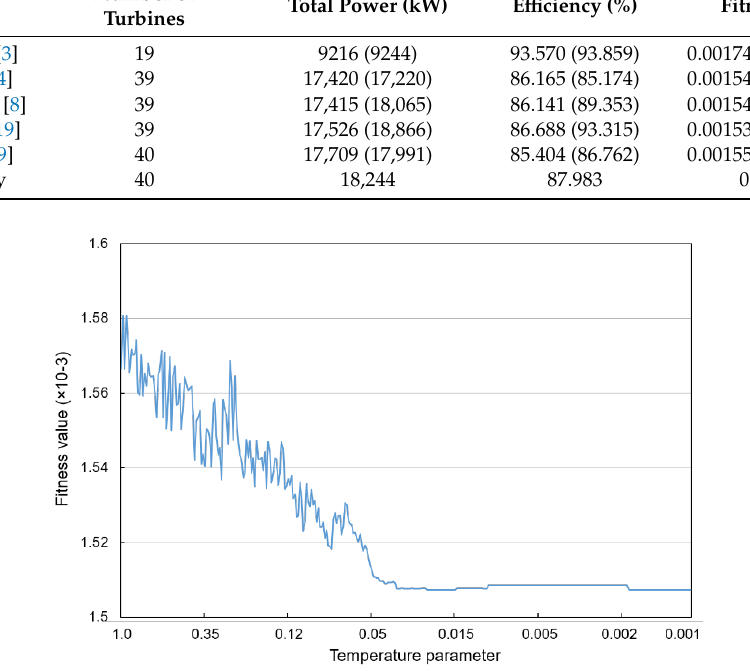
Figure 8. Fitness variation during the process in case study (b). Table 4. Layout Results for Case Study (b).